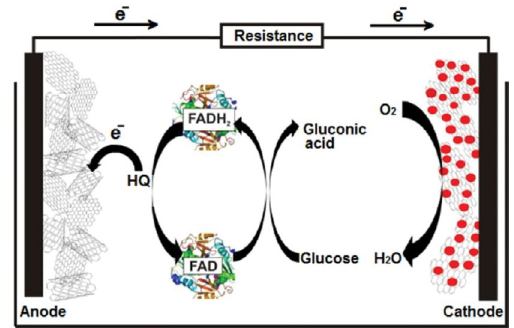
Fig. 8. Schematic representation of the glucose biofuel cell with graphene-multi-walled carbon nanotube/GOx/nafion as ioanode and glassy carbon electrode/ Graphene-Pt composite as cathode [88].